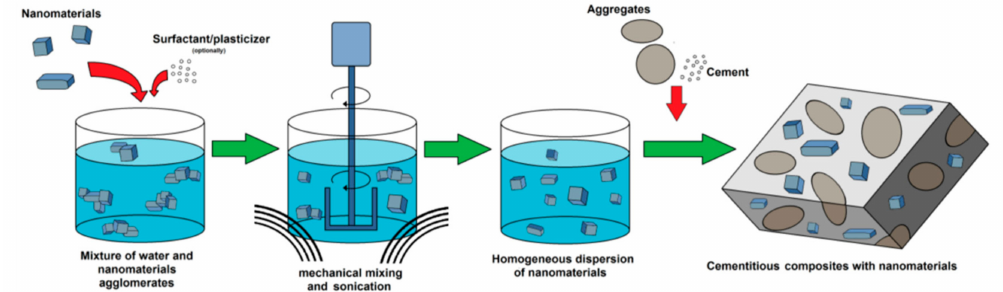
Figure 36. Schematic view of a common nanomaterial dispersion process employed to fabricate a cement-based composite. Reprinted with permission from [167]. Copyright © 2018, MDPI